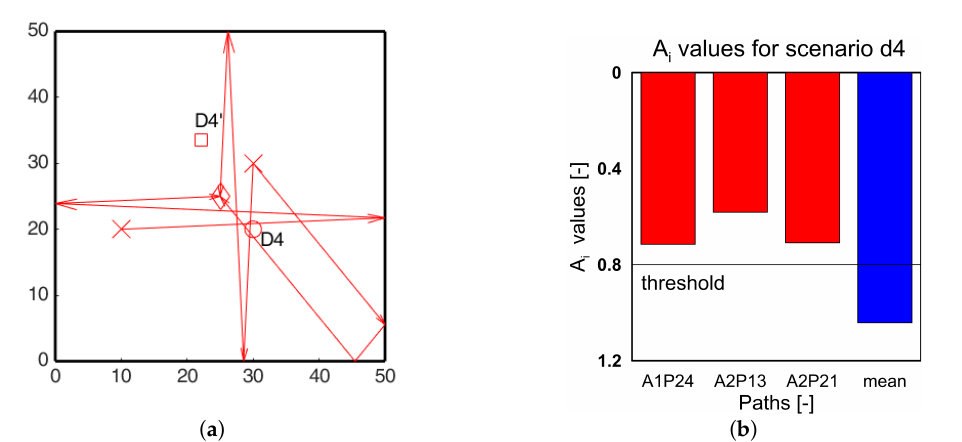
Figure 15. ( a ) Edge reflection paths passing through the identified hotspots; ( b ) A i ratio edge reflection paths passing through the identified hotspots for scenario D4.